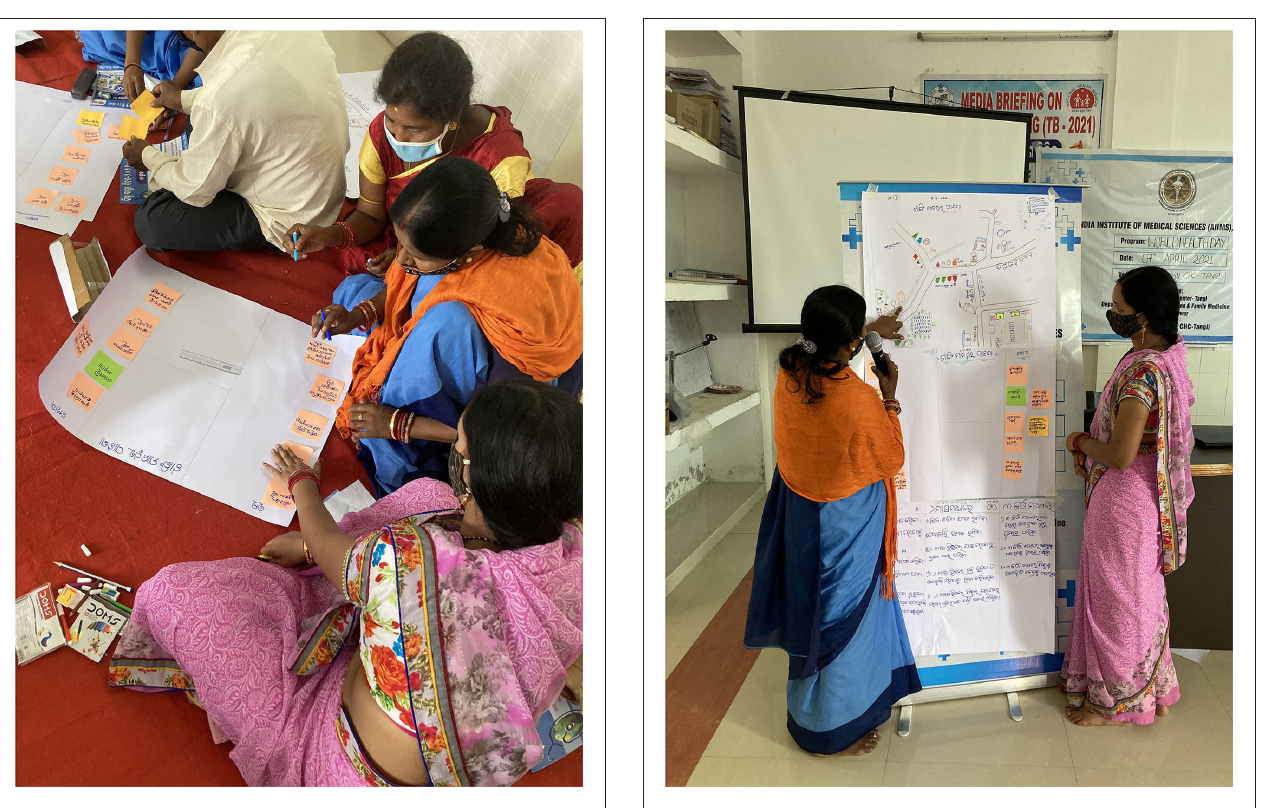
FIGURE 1 | PLA activity. FIGURE 2 | Dissemination and participant driven